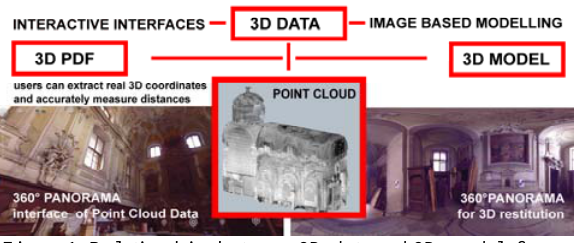
Figure 1. Relationships between 3D data and 3D model: from a point cloud you can have a 3D model or a 360° panorama that could be used as interactive interface to access 3D data. From 360° we can have 3D data and 3D model to interact with